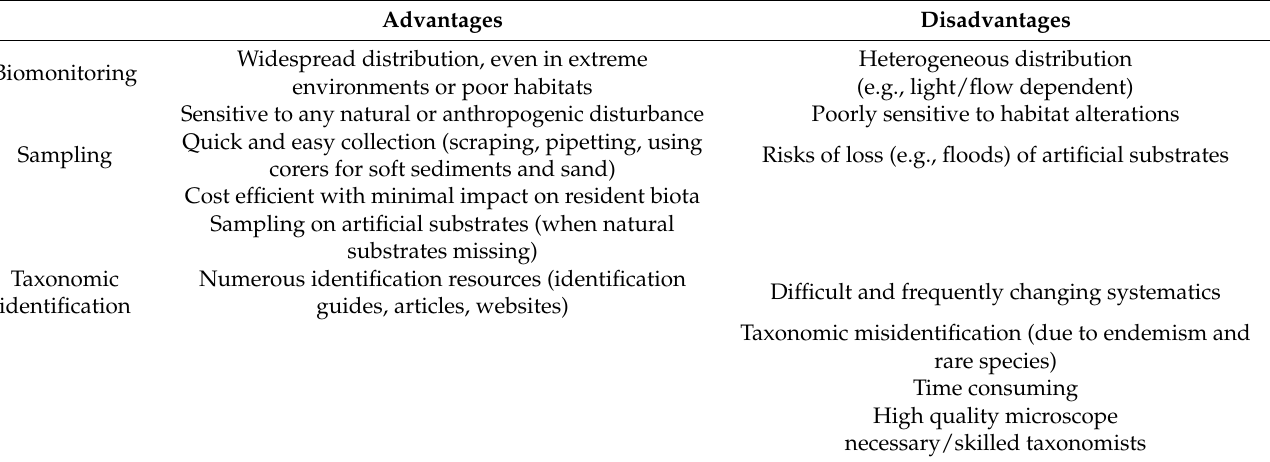
Table 1. Advantages and disadvantages in the use of diatoms as a biological quality element in biomonitoring. Advantages